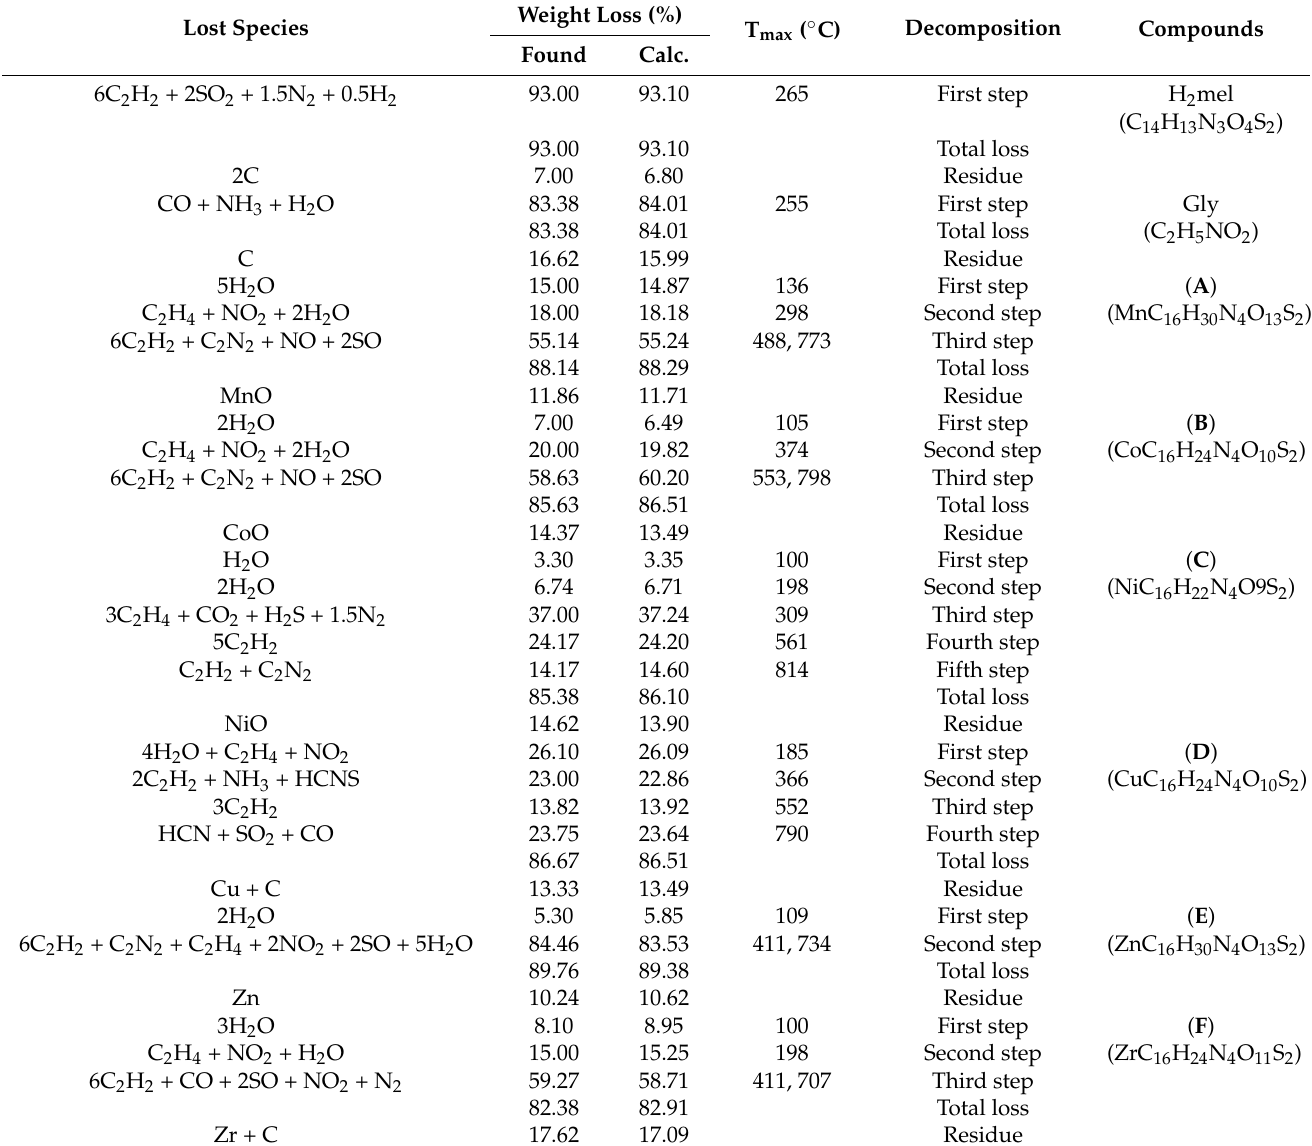
Decomposition Compounds